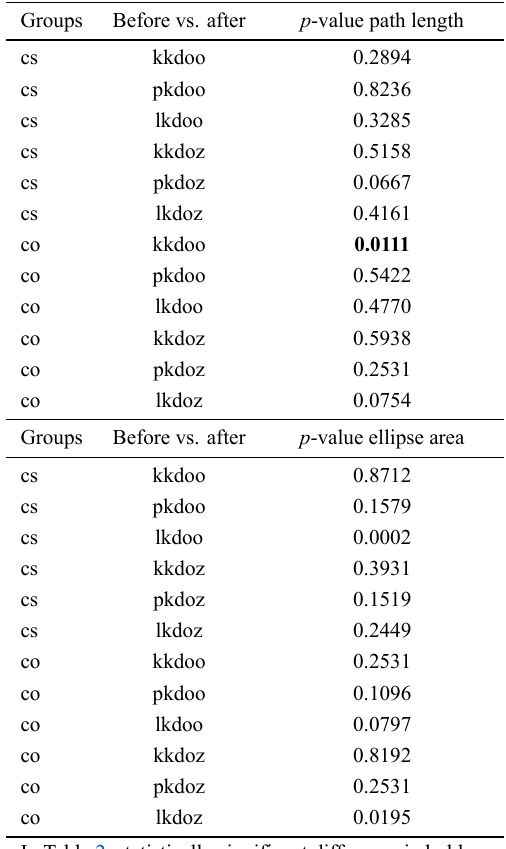
Table 2. Wilcoxon test for path length and ellipse area before starting the study and after five weeks in the craniosacral osteopathic (cs) group and in the control group (co), kkdoo (standing on two legs with eyes open), kdoo (single right leg stance with eyes open), lkdoo (single left leg stance with eyes open), kkdoz (standing on both legs with eyes open), kkdoz (double-legged stance with eyes closed), pkdoz (single right leg stance with eyes open), lkdoz (single left leg stance, eyes